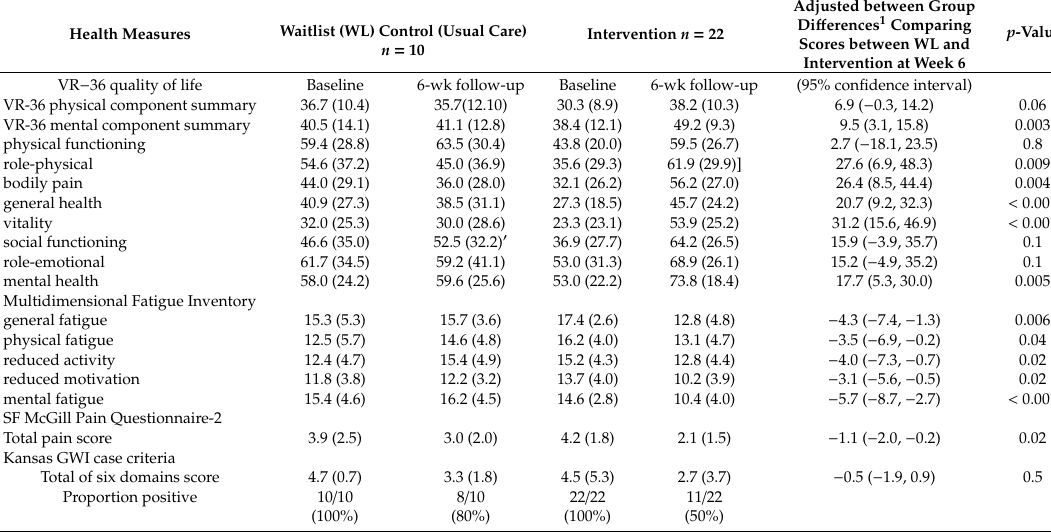
Adjusted between Group Di ff erences 1 Comparing p -Value Intervention n = 22 Scores between WL and n = 10 Intervention at Week 6